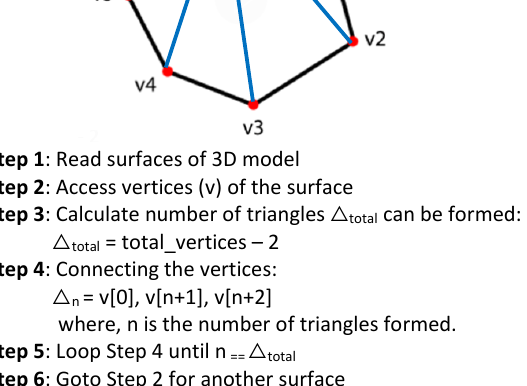
Figure 7. Triangulation technique to repair holes in 3D model.